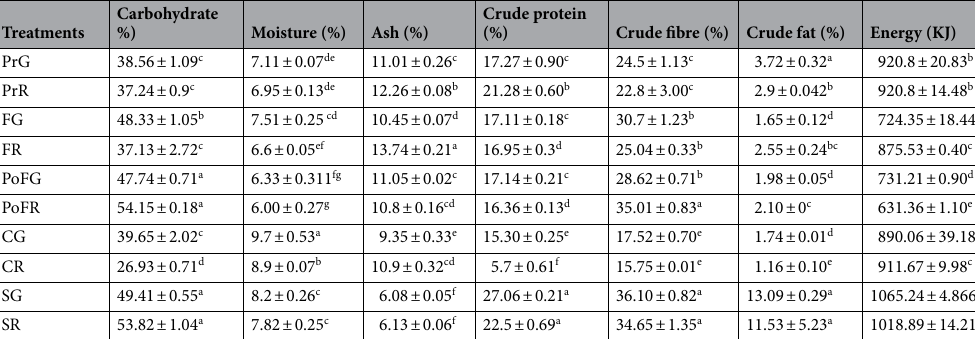
Table 1. Proximate contents of samples of green and red roselle. Values shown are mean ± SD; different letters along a column represent significant differences at p < 0.05 among all the treatments. PrG pre-flowering green, PrR pre-flowering red, FG flowering green, FR flowering red, PoFG post-flowering green, PoFR post-flowering red, CG calyces green, CR calyces red, SG seed green, SR seed